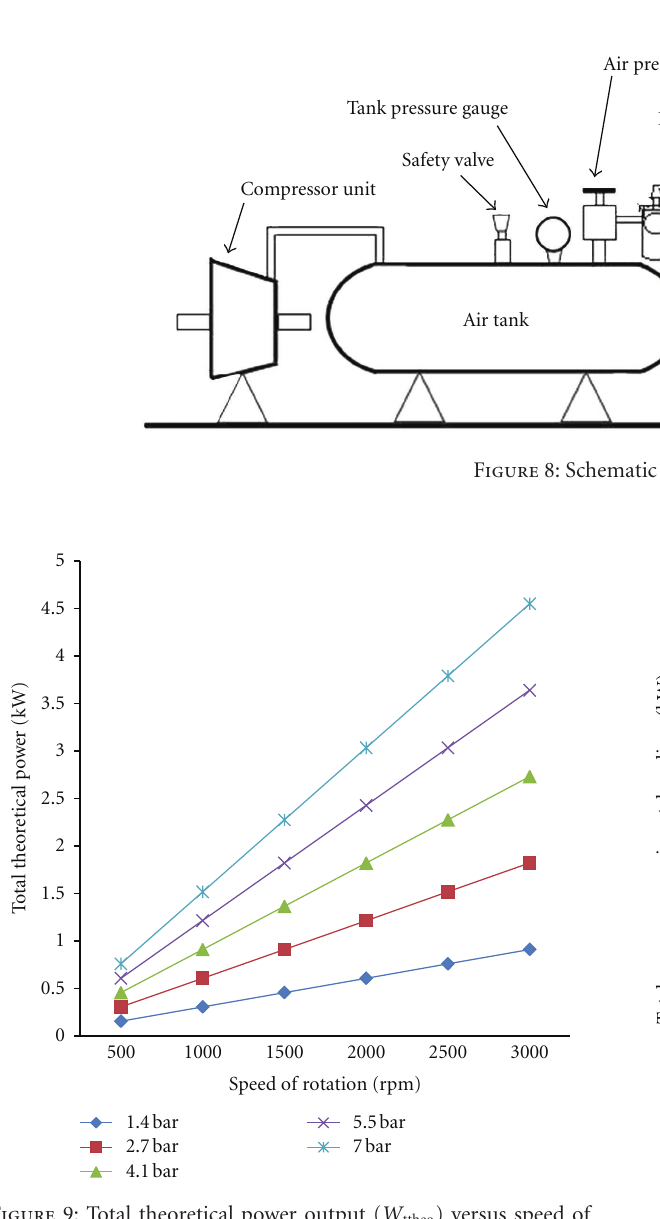
Figure 9: Total theoretical power output ( W ttheo ) versus speed of rotation.